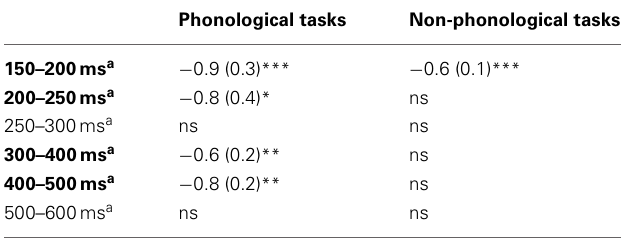
Table 3 | Mean amplitudes ( µ V, standard errors of the mean in parentheses) and their significant difference from 0 μ V of the Nd and Pd effects of visual attention on ERPs to written letters at different time windows from appearance of